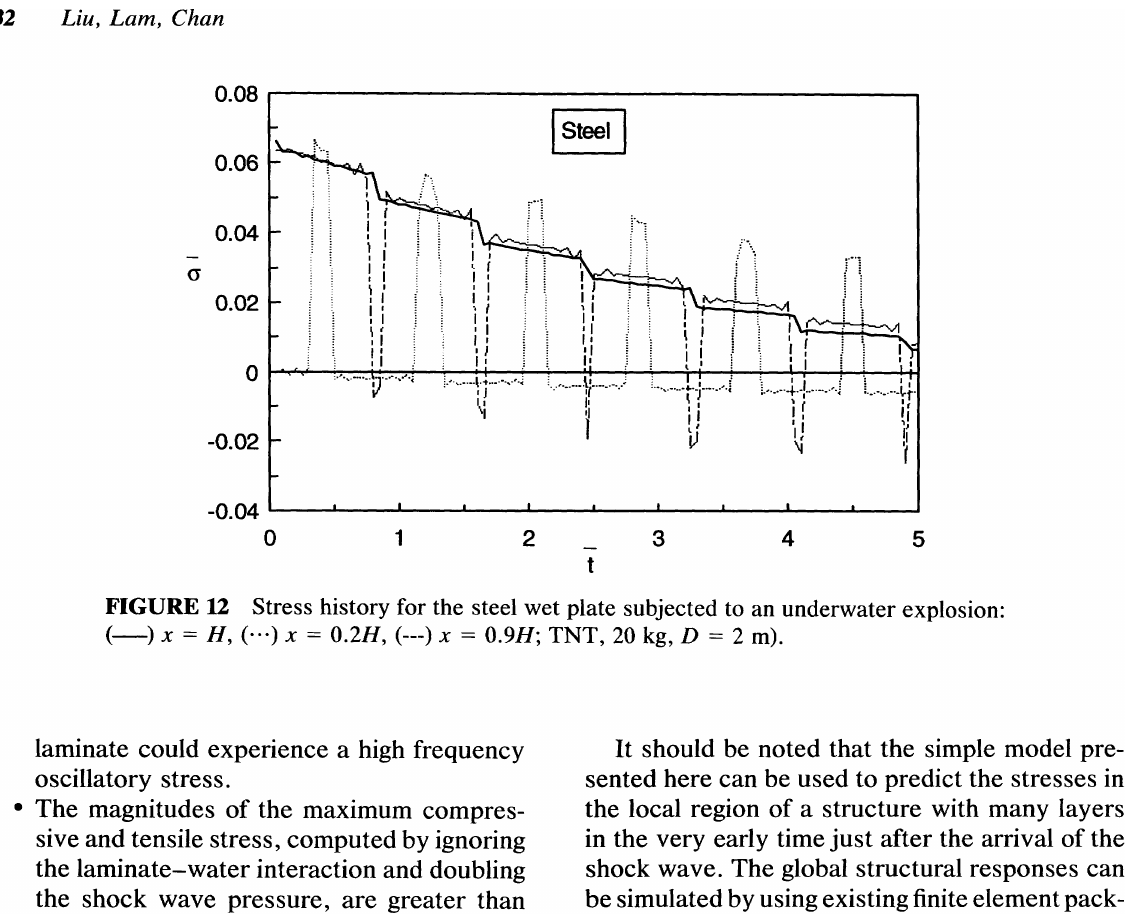
oscillatory stress.